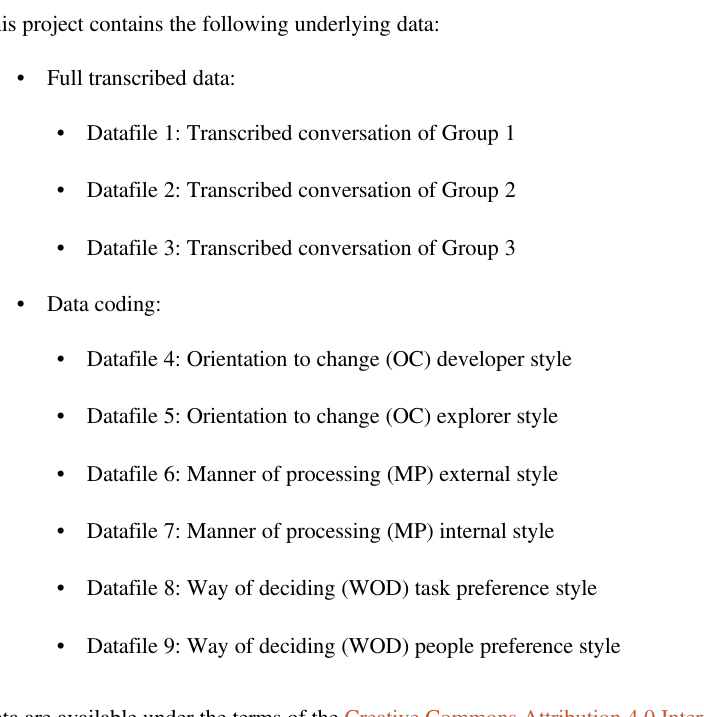
Figshare: Facebook Discussion with Business Experts (transcribed), https://doi.org/10.6084/m9.figshare.16811542. v2. 26 This project contains the following underlying